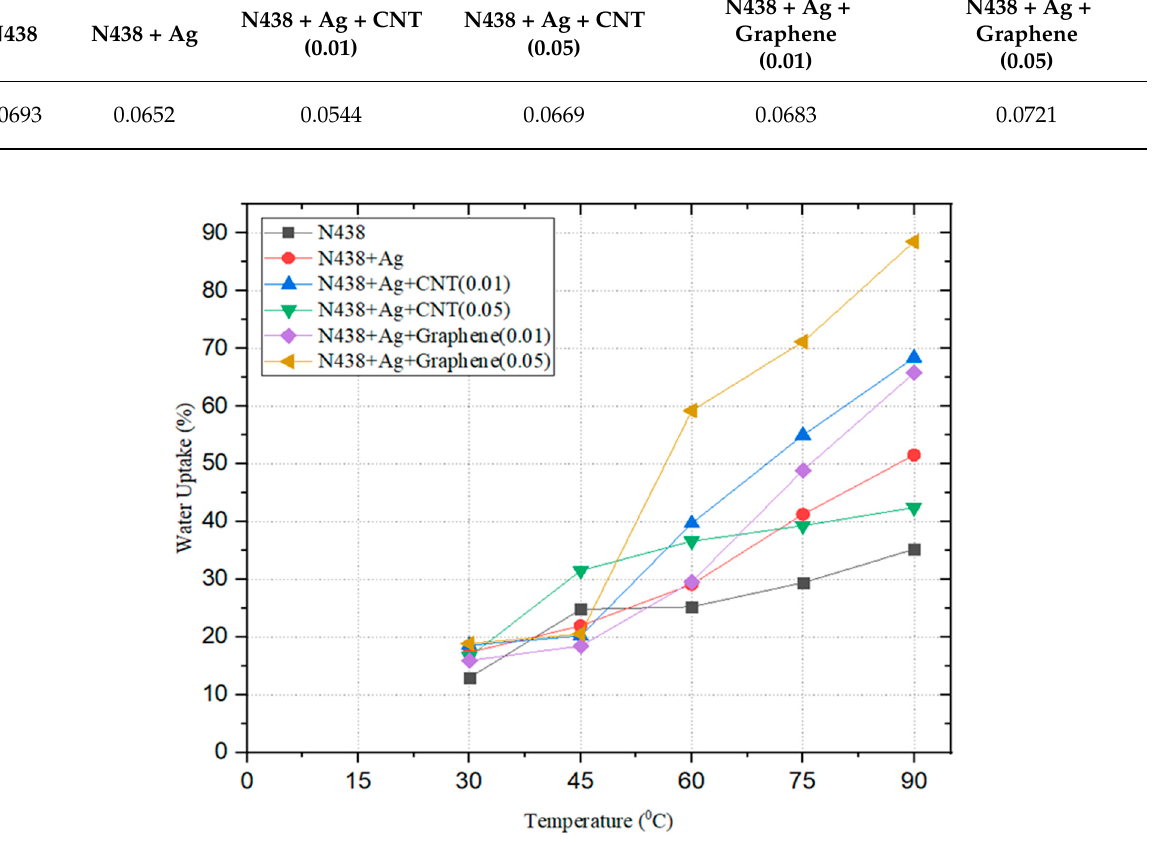
Figure 8. Water uptake % vs. Temperature. Table 4. Weight of the Samples after immersion in hot water and their respective water uptake.